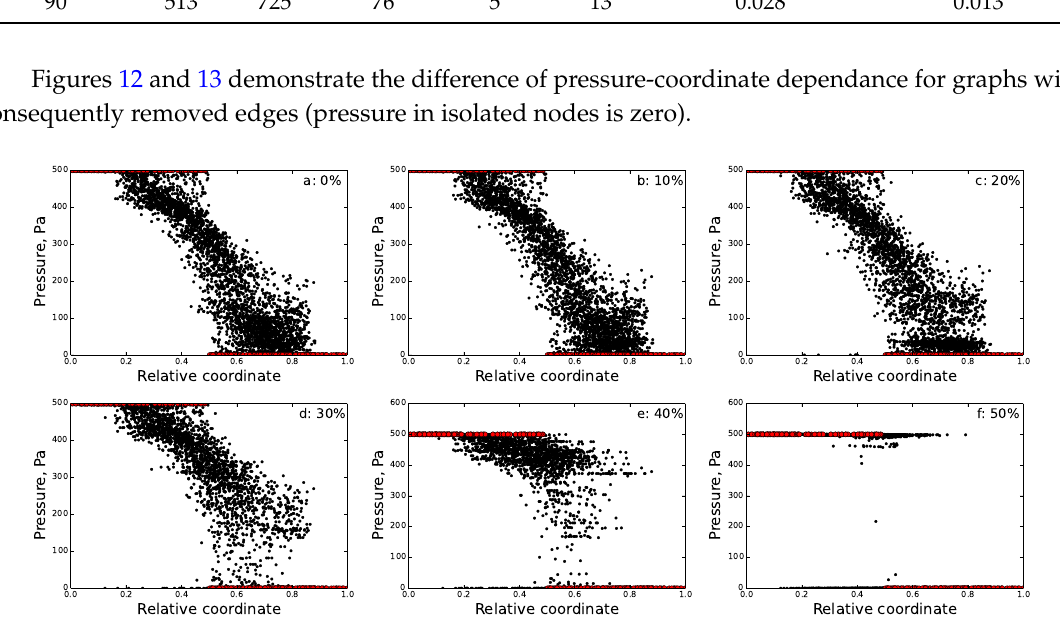
Figure 12. Pressure gradient for ( a – f ) 0%–50% edges removed (constant boundary conditions). Boundary points are highlighted in red.